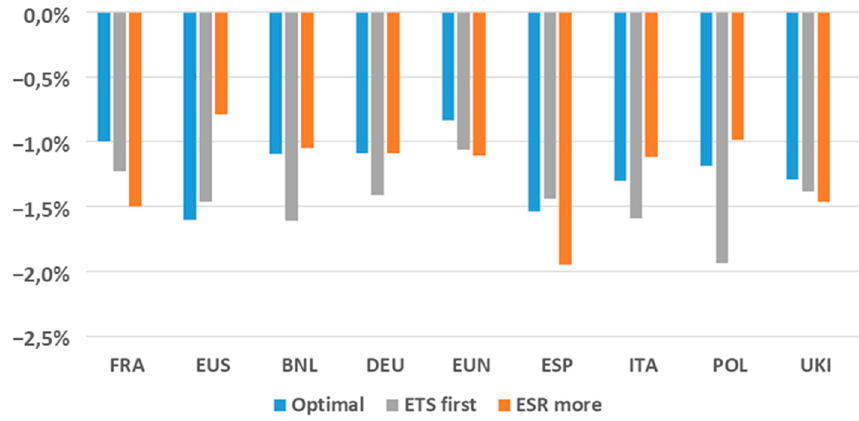
Figure 9. Deviation of EU regional GDP in 2030 compared to the reference scenario.